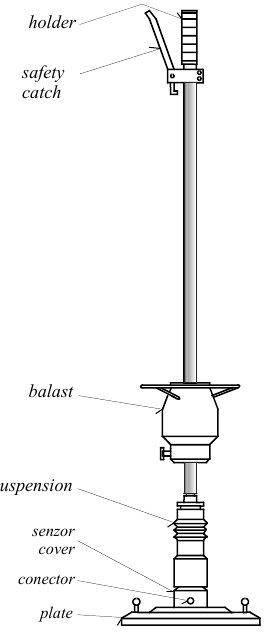
Figure 3. Lightweight Dynamic Plate Testing device LDD 100.